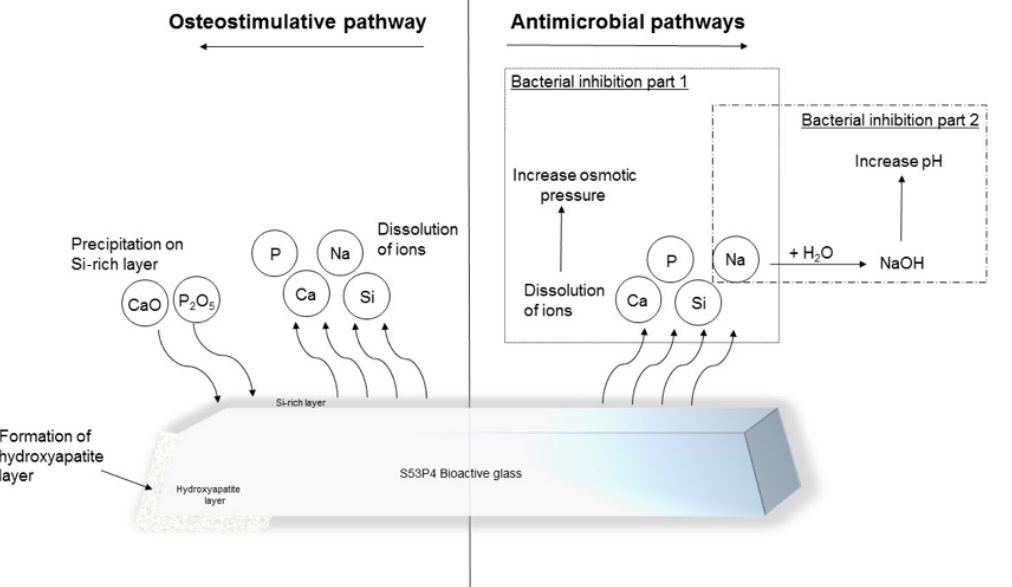
Figure 1. Illustration of the osteostimulative and antimicrobial pathways of S53P4 bioactive glass (Bonalive ®